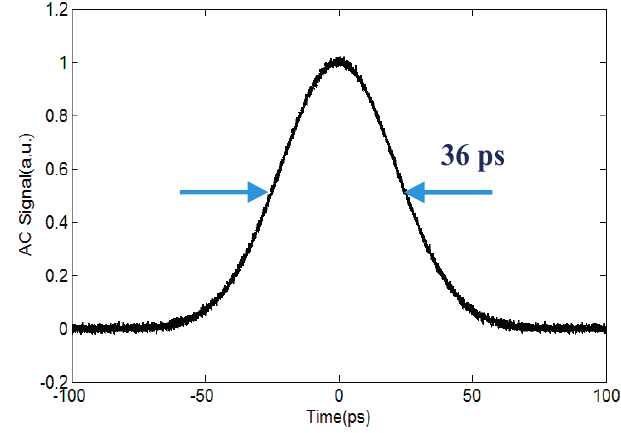
Figure 7. Autocorrelation signal of pulse output from the regenerative amplifier.